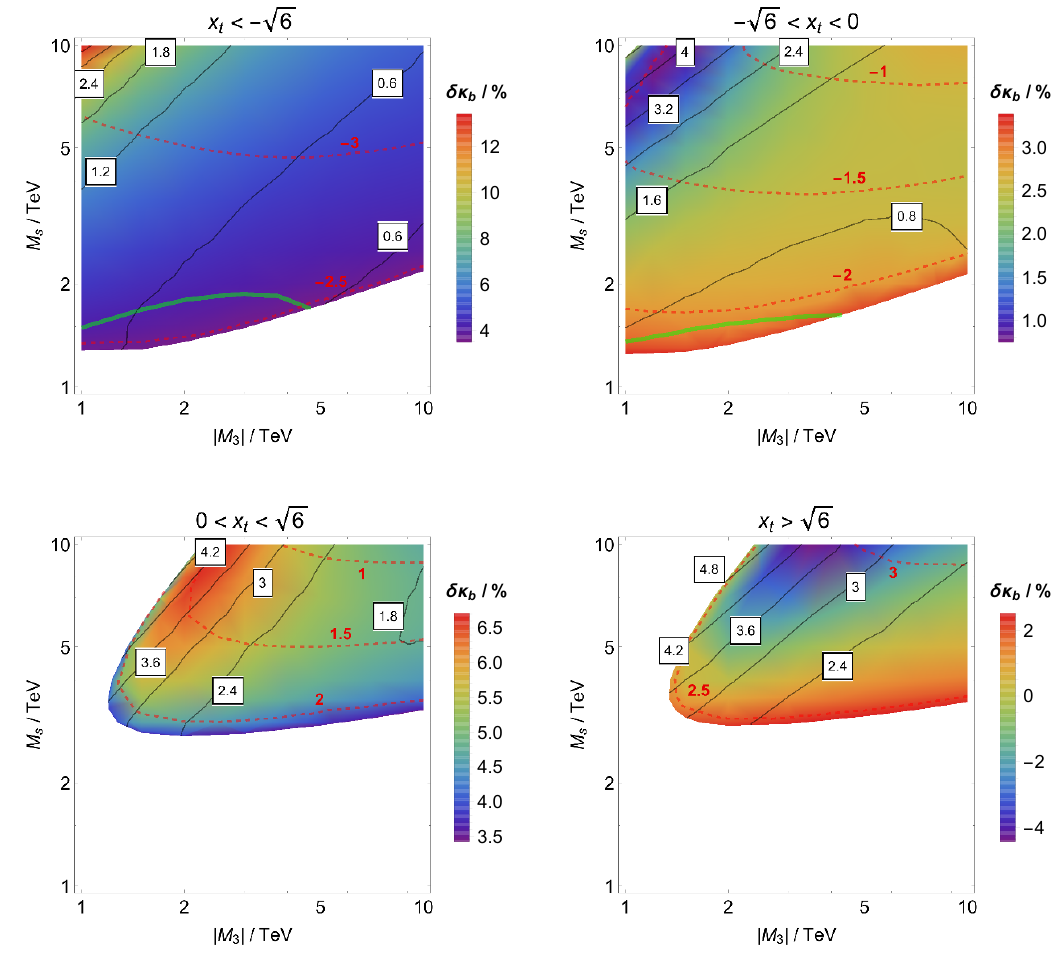
Figure 6 . Same as (cid:12)gure 5, now with tan (cid:12) =